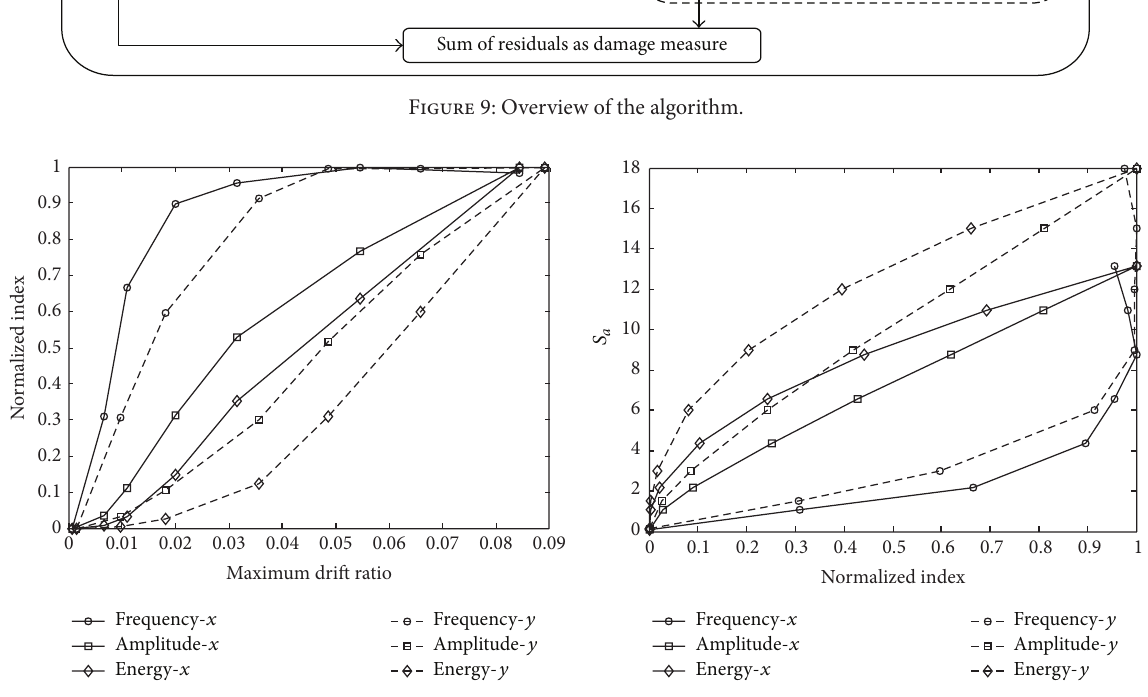
Figure 10: Correlation of feature indexes with (a) maximum drift ratio and (b) spectral